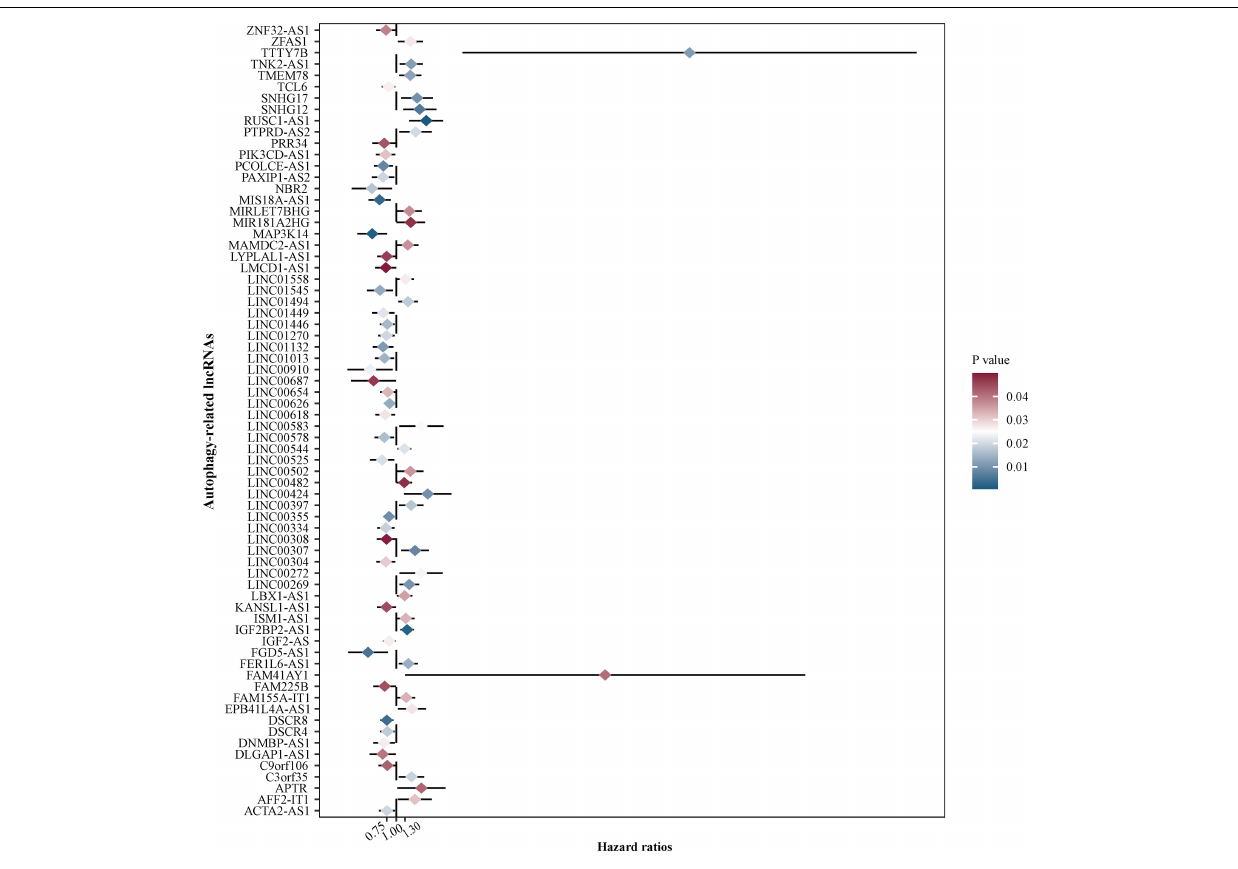
FIGURE 3 | Identification of autophagy-related lncRNAs with prognostic value in osteosarcoma. We performed univariate Cox regression analyses and identified 69 autophagy-related lncRNAs associated with osteosarcoma patient prognosis. Red color represents high P -values, whereas blue color represents low P -values.